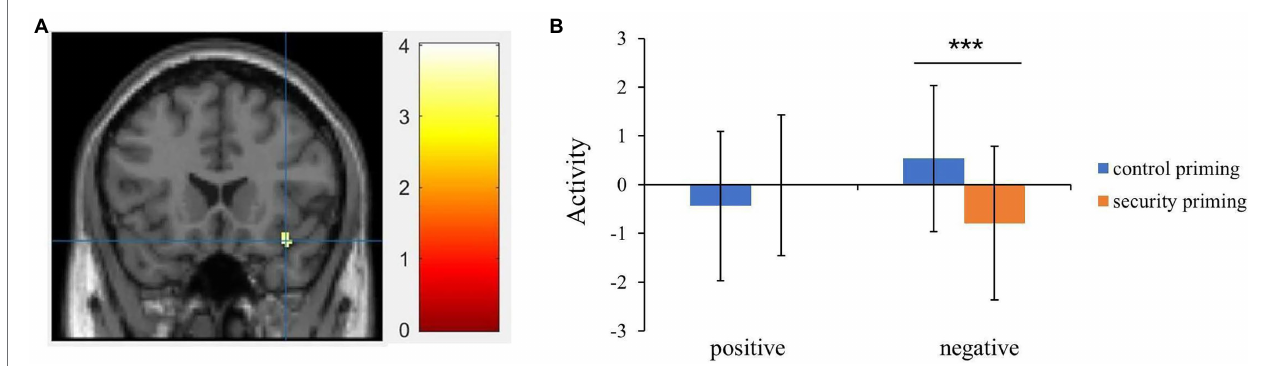
FIGURE 1 | (A) The interaction between priming (attachment security priming vs. control priming) and valence (positive vs. negative) showed activation in right inferior frontal gyrus (extended to insula). (B) Extracted beta values from inferior frontal gyrus showed the activation pattern between control priming and attachment security priming conditions. Error bars indicate the standard deviation of means (*** p < 0.001).